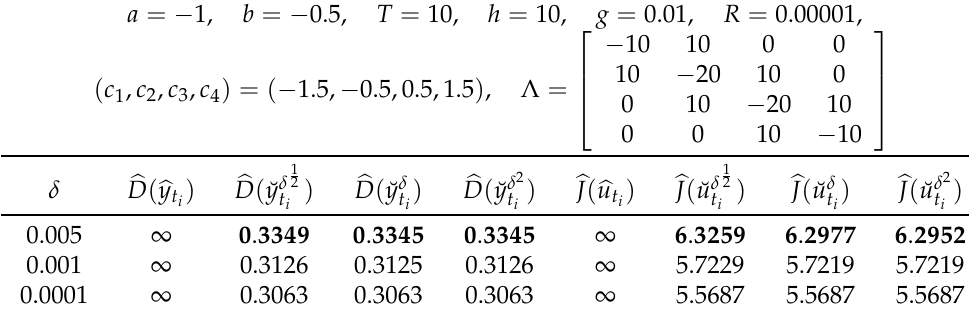
Table 6. The results with the CTMC dimensionality 4 and transition intensities 10.